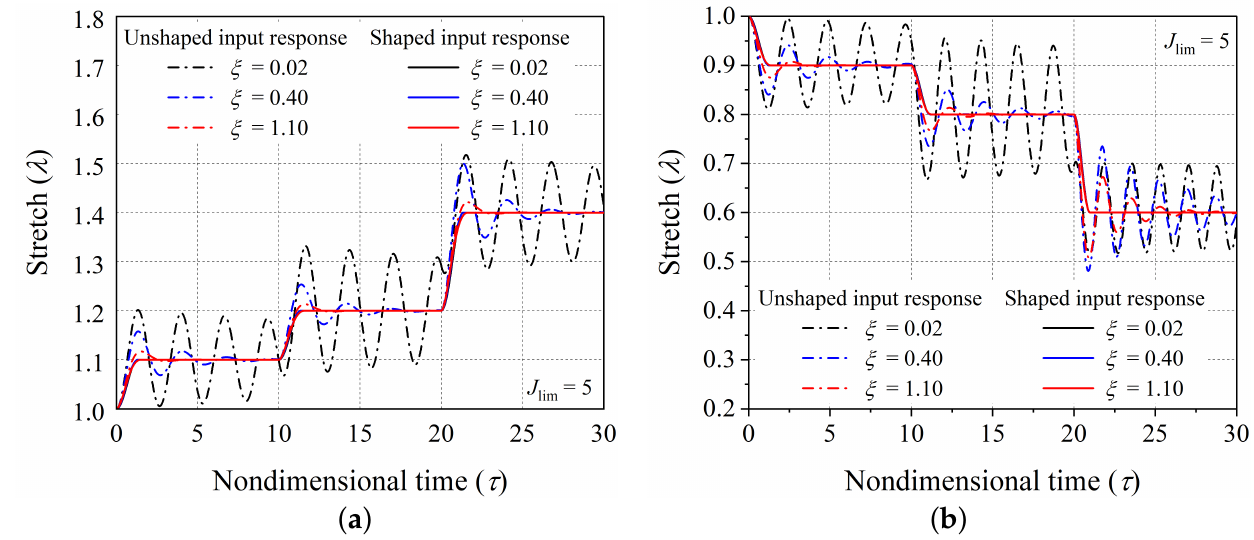
Figure 7. The controlled transient response (corresponding to shaped input signal) and uncontrolled transient response (corresponding to unshaped input signal) of the hard-magnetic soft actuator for different values of nondimensional damping coefficient ξ , in the ( a ) expansion mode of operation, and in the ( b ) contraction mode of